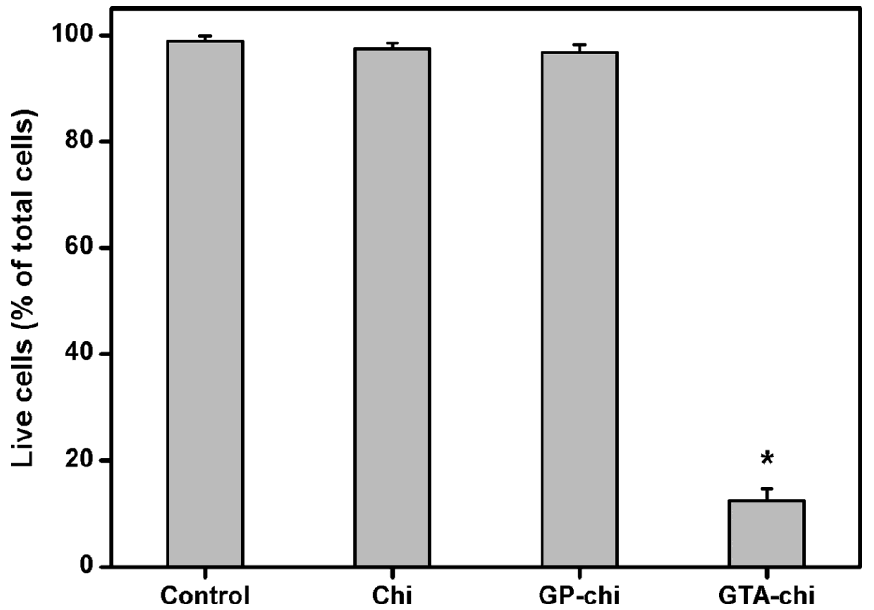
Figure 5. Mean percentage of live cells in the ARPE-19 cultures exposed to various chitosan membranes (5 mg) as measured by the Live/Dead assay. An asterisk indicates statistically significant differences (* p < 0.05; n = 3) as compared to controls (without